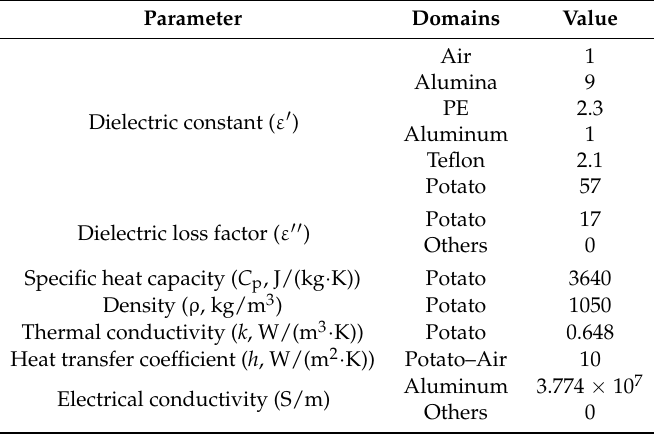
Table 1. Summary of material properties applied in the model.